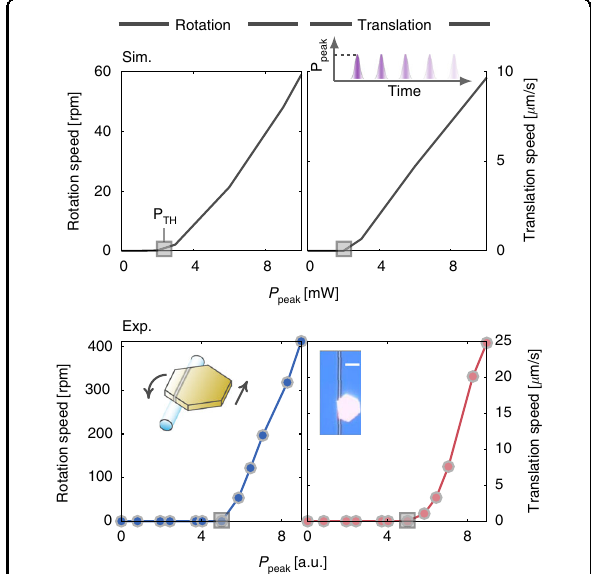
Fig. 5 Observation of sliding threshold power PTH in spiral motion of gold plates. The numerical results of rotation and translation speeds as functions of absorbed peak power (top panel) for rectangular gold plates [same as those studied in Fig. 4c (rotation) and d (translation), respectively] feature the mW-scale sliding power threshold P TH , which qualitatively agree with the measurement results (lower panel) for a hexangular plate (same as in Fig. 2b). The numerical simulations adopt the same parameters of the pulsed absorbed optical power, the micro- fi ber, and the frictional sliding resistance as in Fig. 4c – d. The experimentally used super-continuum laser pulses have 6.8-mW average power, 2.6-ns temporal width and 17.50-kHz repetition rate. The scale bar in the inset optical image is 15